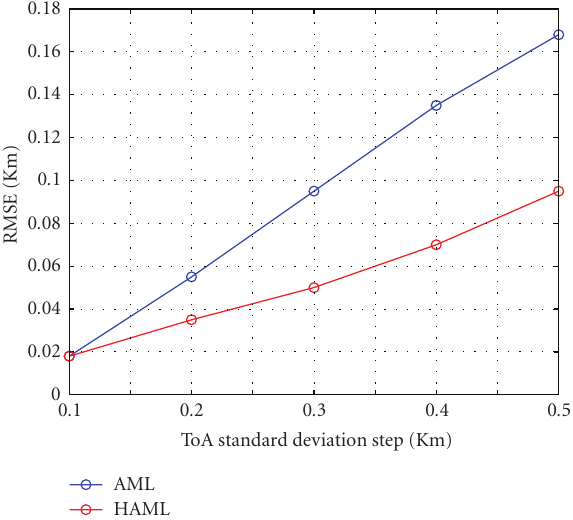
Figure 2: Influence of the variability of TOA variances between BSs on the position accuracy with 2-BS HAML and 3-BS AML techniques.